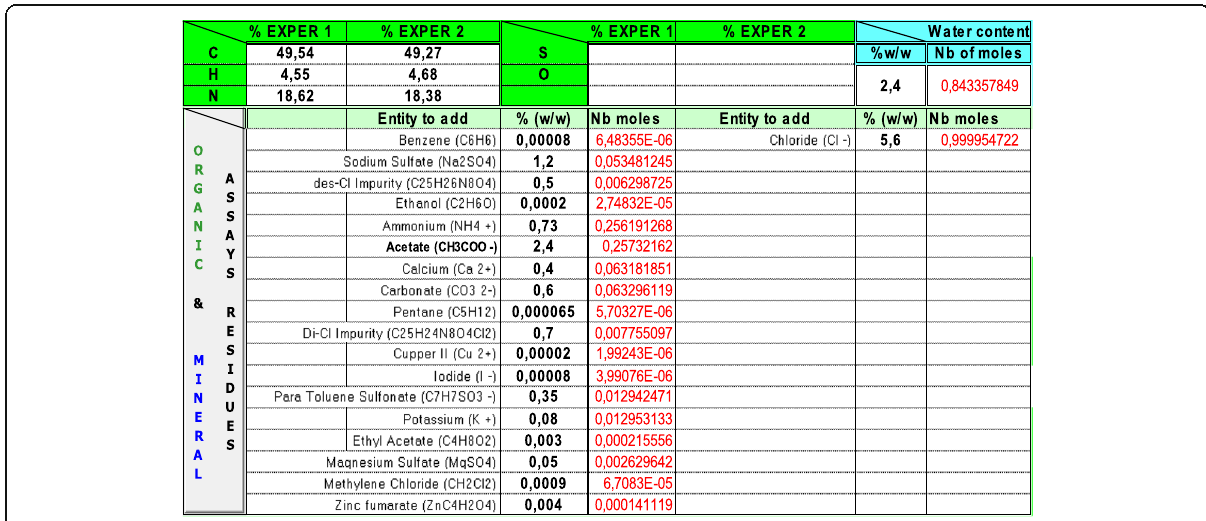
Fig. 3 User interface screenshot –– experimental Elemental Analysis results (CHNSO) –– recalculated nb of moles of water (8th column) –– recalculated nb of moles (5th and 8th columns) of each of the 20